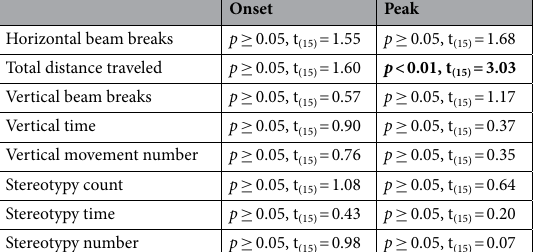
Table 6. Comparison of the self-administration and non-contingent administration R14 meth/rotenone animals. Student’s t test with Bonferroni α correction of 0.025 for multiple